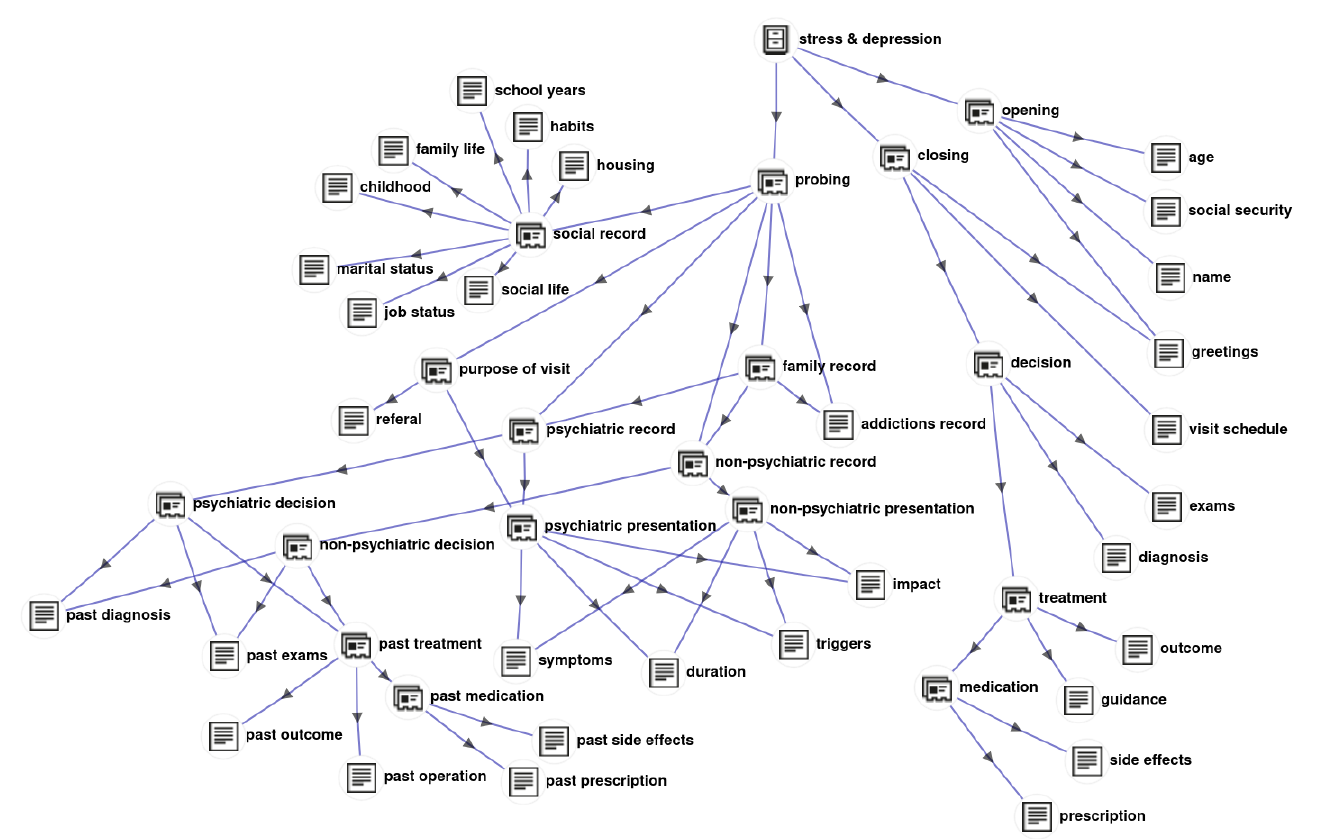
Figure 2. The proposed hierarchical ontology for labeling the parts of a psychiatric interview. Reprinted with permission from [14]. Copyright 2021 Association for Computing Machinery